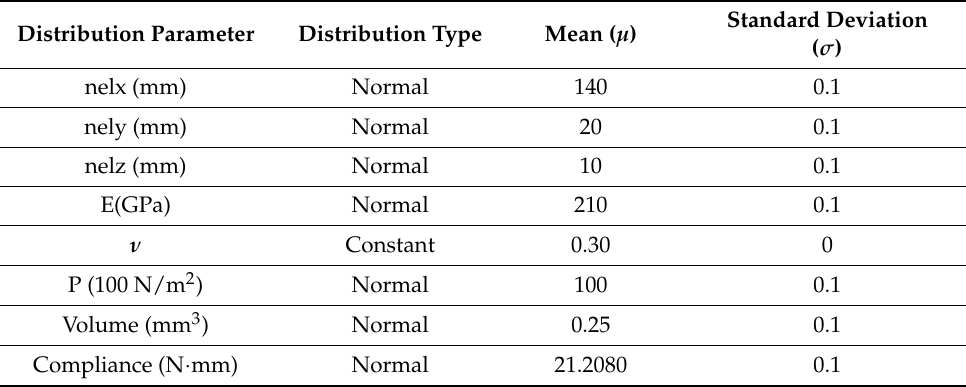
Table 4. Parameters related to the design domain.